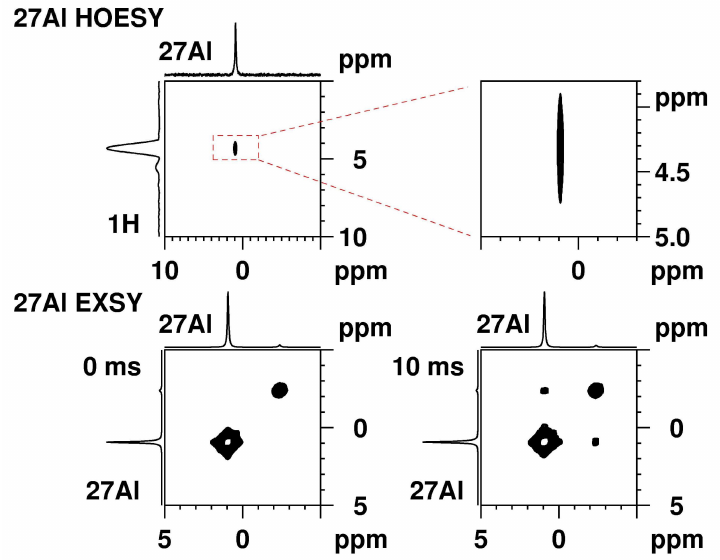
Figure 2. ( top ) 27 Al heteronuclear Overhauser effect spectroscopy (HOESY) spectrum of Al 2 (SO 4 ) 3 recorded in L1 solution at pH 3 with 30 ms mixing time ( left ) with the region characteristic for hexa-coordinated aluminium (magnified, right ); ( bottom ) 27 Al exchange spectroscopy (EXSY) spectra recorded with 0 ms mixing time ( left ) as a reference spectrum and 10 ms mixing time ( right